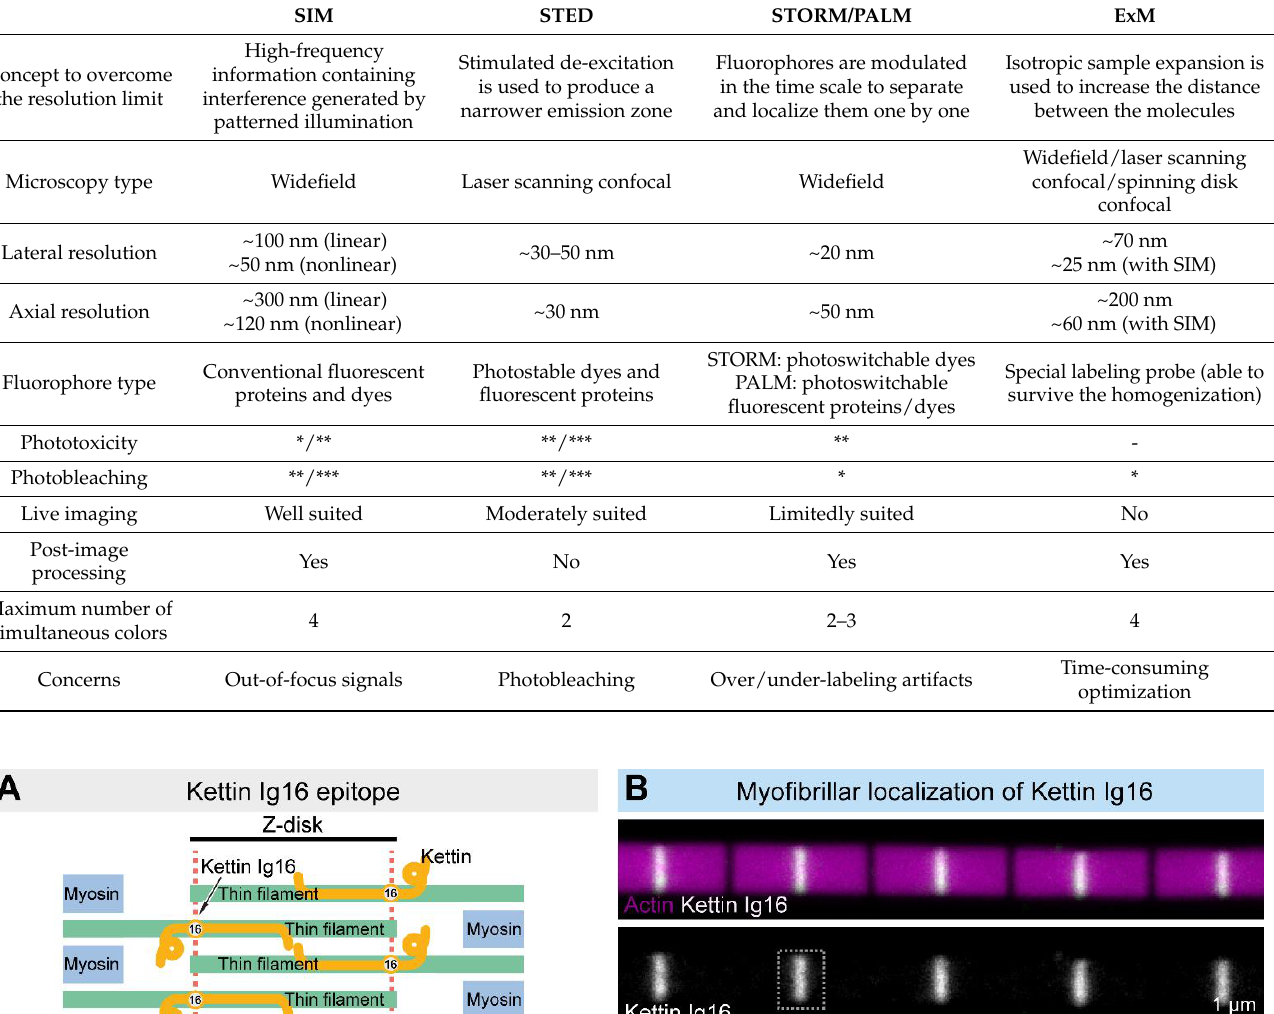
Table 1. Comparison of the different SRM techniques. *: low, **: medium, ***: high.